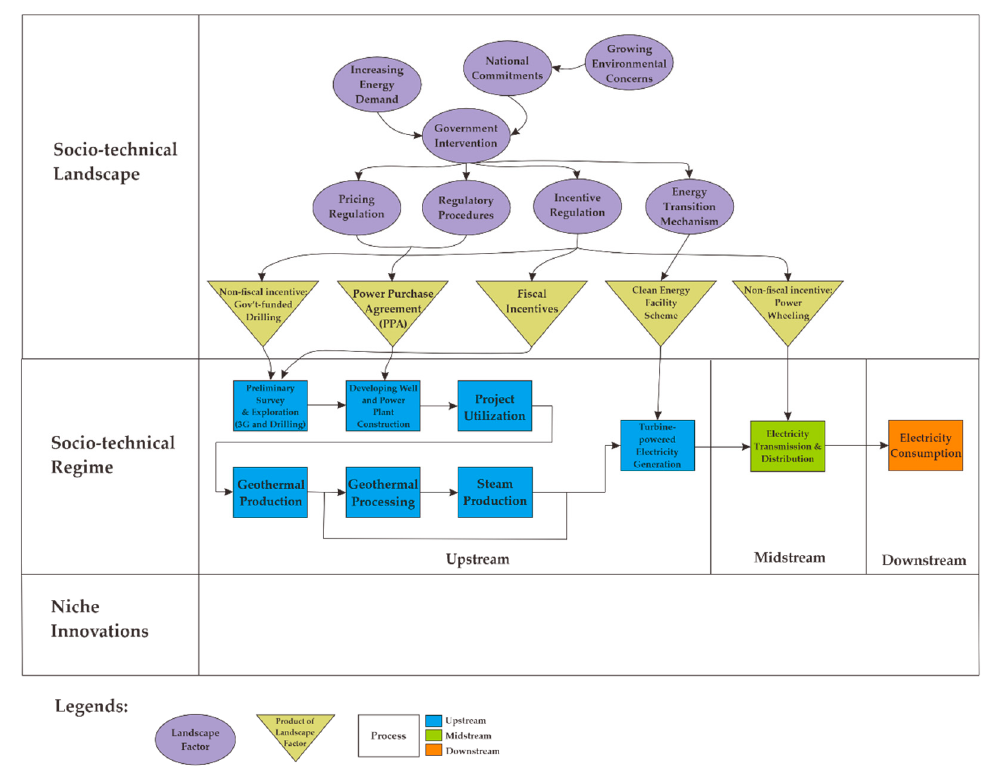
Figure 2. MLP diagram for geothermal energy as the new regime.